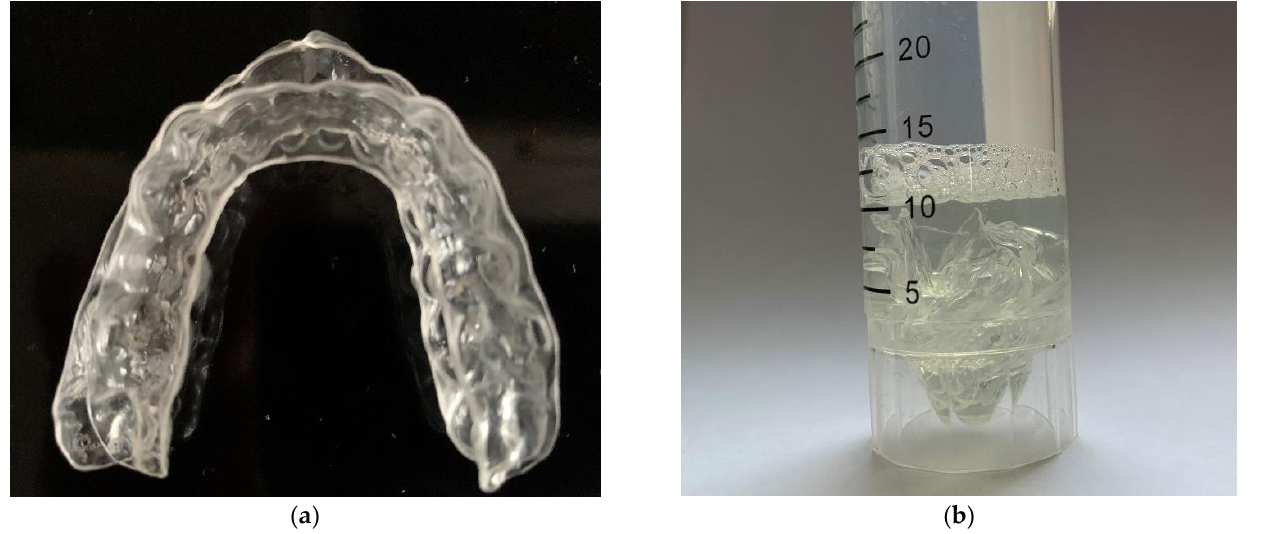
Figure 1. ( а ) used aligners from one patient; ( b ) aligners sliced and placed in a solution. Figure 1. ( a ) used aligners from one patient; ( b ) aligners sliced and placed in a